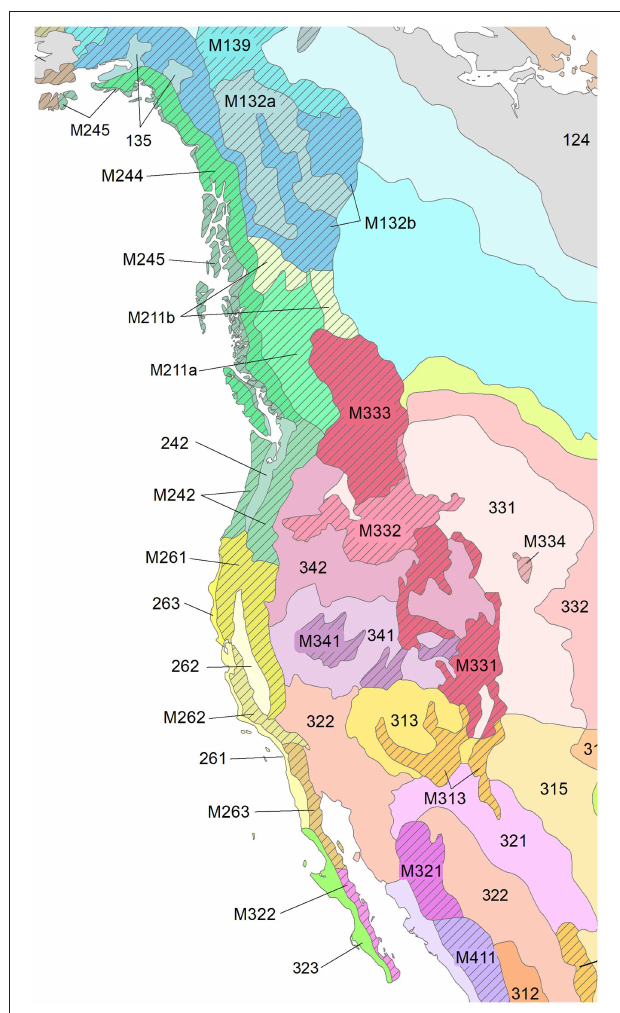
FIGURE 2 | Bailey provinces of western North America (Bailey, 1998). 135—Taiga—tundra, medium, M132a—Taiga—tundra,